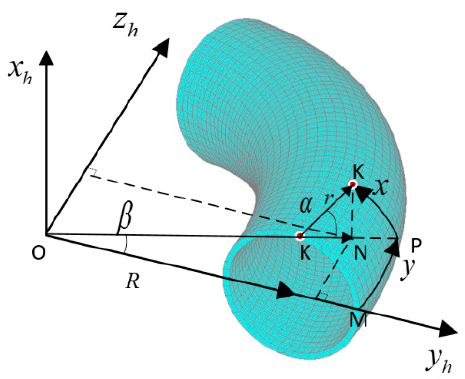
Figure 1. Coordinate system used to simplify forward model.